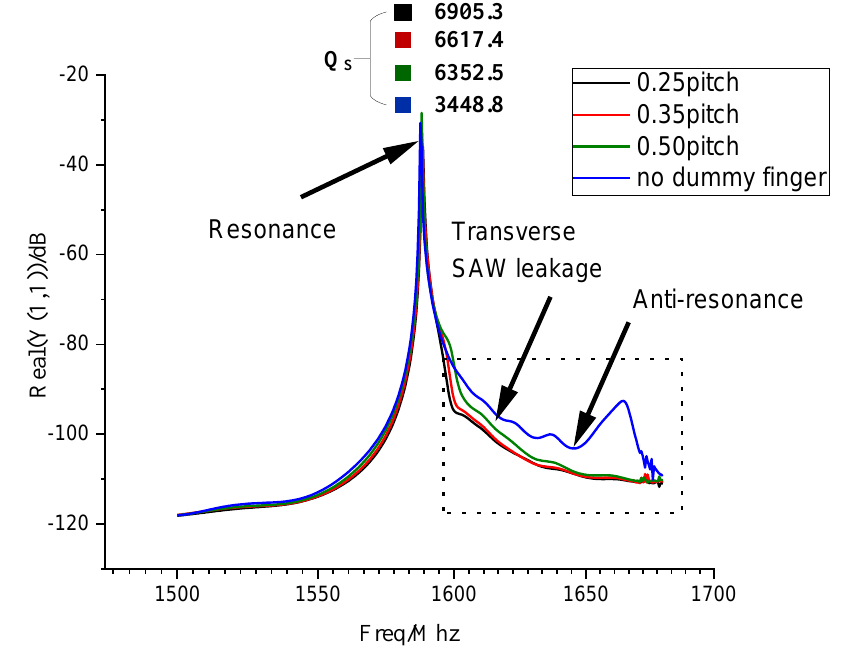
Figure 4. Comparison of conductance with and without dummy electrodes. First, two cases were simulated: one without virtual electrodes and the other with virtual electrodes. Then, three gaps were simulated in the case of virtual electrodes: 25% pitch, 35% pitch and 50% pitch. In the dotted black box, if the curve’s position is lower, the degree of lateral SAW leakage is more